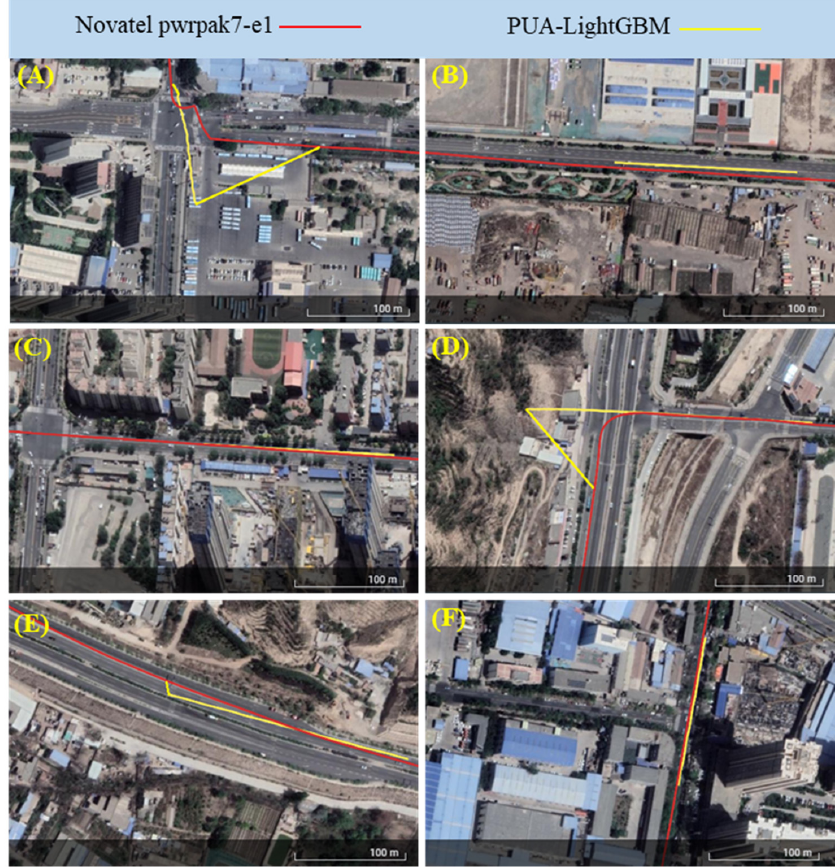
Figure 4. The vehicle trajectories outputted by PUA-LightGBM (in yellow) and Novatel pwrpak7-e1 (in red) on six road segments of the field test. ( A ) Turn and downslope road, ( B ) straight and level road, ( C ) straight and upslope road, ( D ) turn and upslope road, ( E ) straight and level road, ( F ) straight and downslope road.